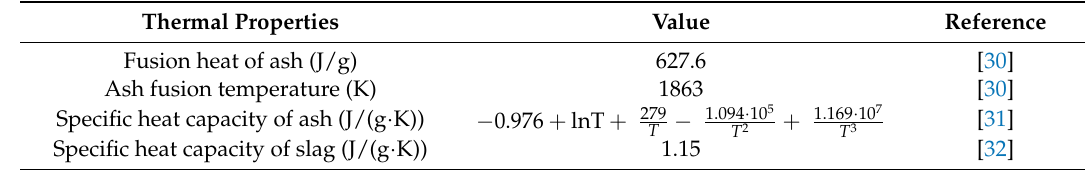
Table 6. Thermal properties of ash and slag used in this study.